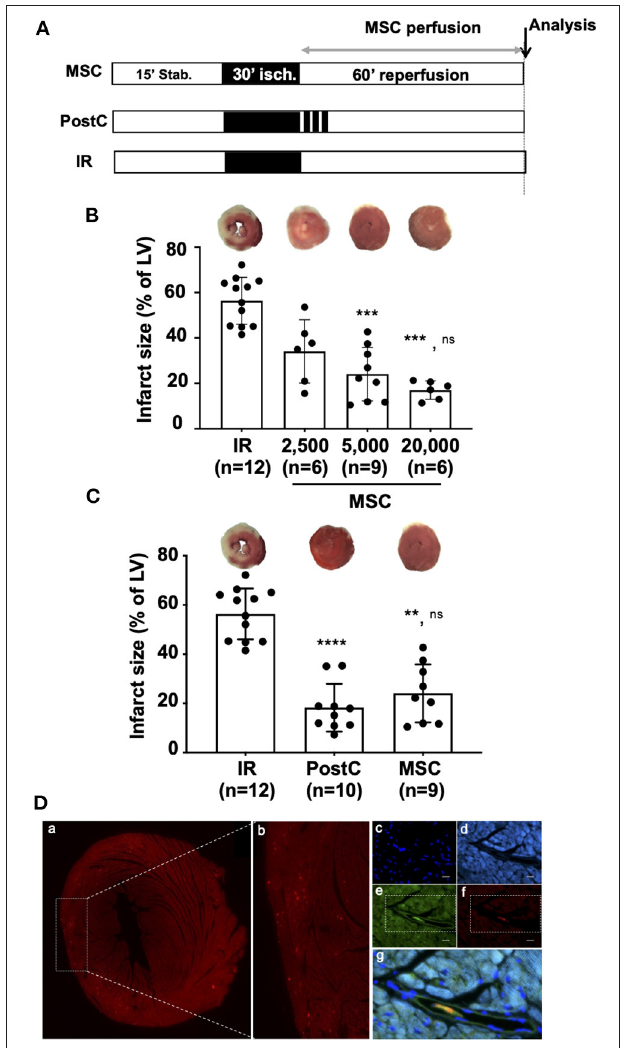
FIGURE 2 | (A) Isolated hearts perfused ex vivo on the Langendorff system were submitted to perfusion protocol similar to that described in Figure 1A . In the MSC group, reperfusion was achieved with a solution of MSC cells prepared in a Tyrode buffer at various concentrations (2,500; 5,000; or 20,000 cells/mL). For the PostC group, a postconditioning stimulus comprising three cycles of 1min ischemia-1min reperfusion was applied at the onset of reperfusion. In the control condition (IR), hearts were reperfused with Tyrode solution alone (control condition). Histological analysis was performed at the end of the protocols for infarct size measurement and immunochemistry. (B) Scatter plots and bars (mean ± SD) were represented for infarct size (in % of LV) in IR ( n = 12), MSC 2,500 cells/ml ( n = 6), MSC 5,000 cells/ml ( n = 9), and MSC 20,000 ( n = 6). Representative pictures of TTC-stained LV slices were shown for each group. Statistical analysis was performed using Kruskal-Wallis with the Dunn’s post hoc test for multiple comparison. Statistical significance is noted *** for p = 0.0009 (MSC 5,000 vs. IR), *** for p = 0.0003 (MSC 20,000 vs. IR) and ns for p > 0.99 (MSC 20,000 vs. MSC 5,000). (C) Scatter plots and bars (mean ± SD) were represented for infarct size (in % of LV) in IR ( n = 12), PostC ( n = 10), and MSC (5,000 cells/ml, n = 9). Representative pictures of TTC-stained LV slices were shown for each group. Statistical analysis was performed using Kruskal-Wallis with the Dunn’s post hoc test for multiple comparison. Statistical significance is noted **** for p > 0.0001 (PostC vs. IR), ** for p = 0.0018 (MSC vs. IR) and ns for p > 0.99 (PostC vs.